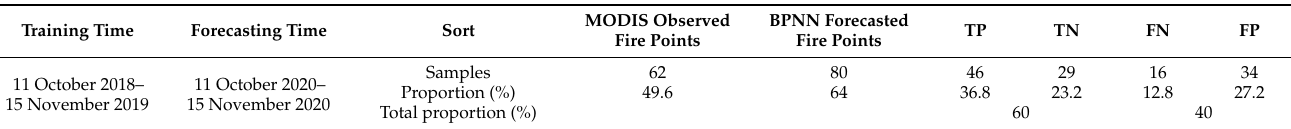
Table 5. Results of the BPNN in forecasting fire points over Northeastern China in 2020 after adding anthropogenic management and control policy